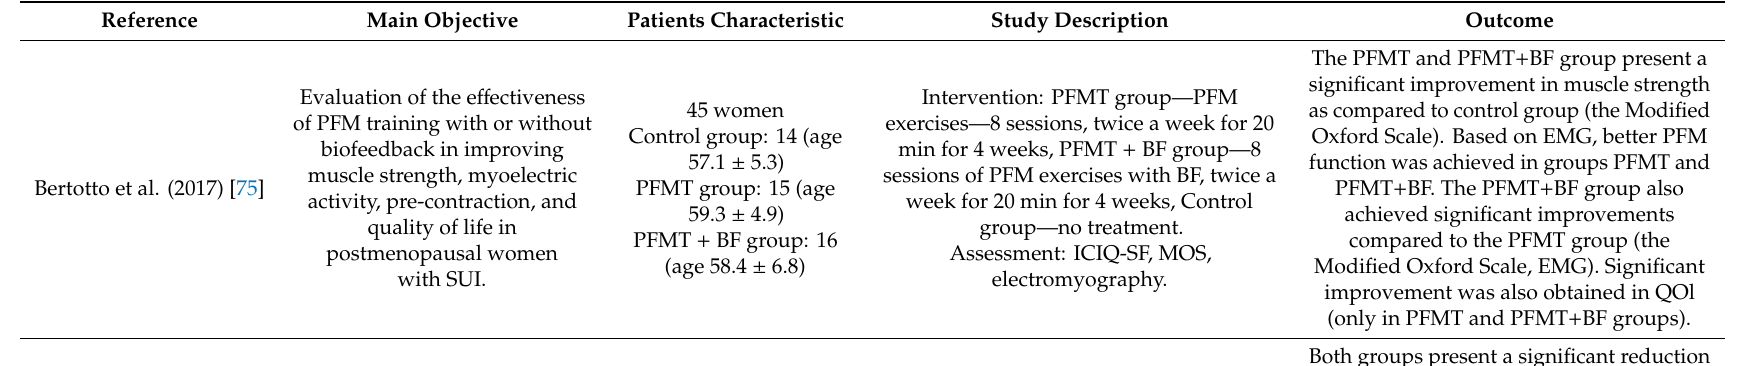
Table 2. Characteristic of selected studies on the e ff ects of pelvic floor muscle training and biofeedback on the pelvic floor muscles (PFM) activity and / or severity of urinary incontinence